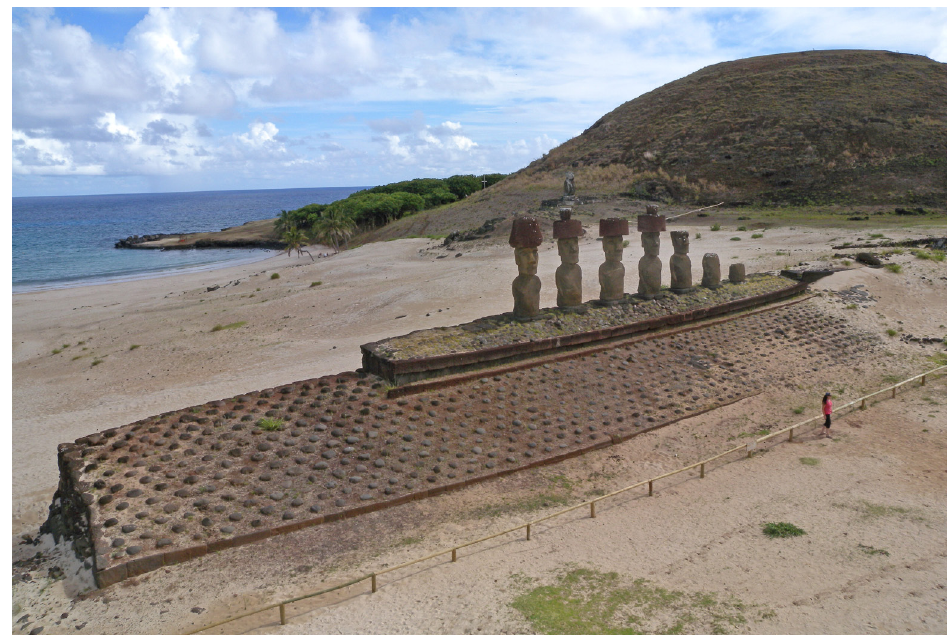
Fig. 1: Ahu Nau Nau, showing the canoe-shaped ahu platform, its poro (sea boulder) ramp and partly poro -paved plaza on the landward side, and Rano Raraku statues with pukao (‘hats’) in